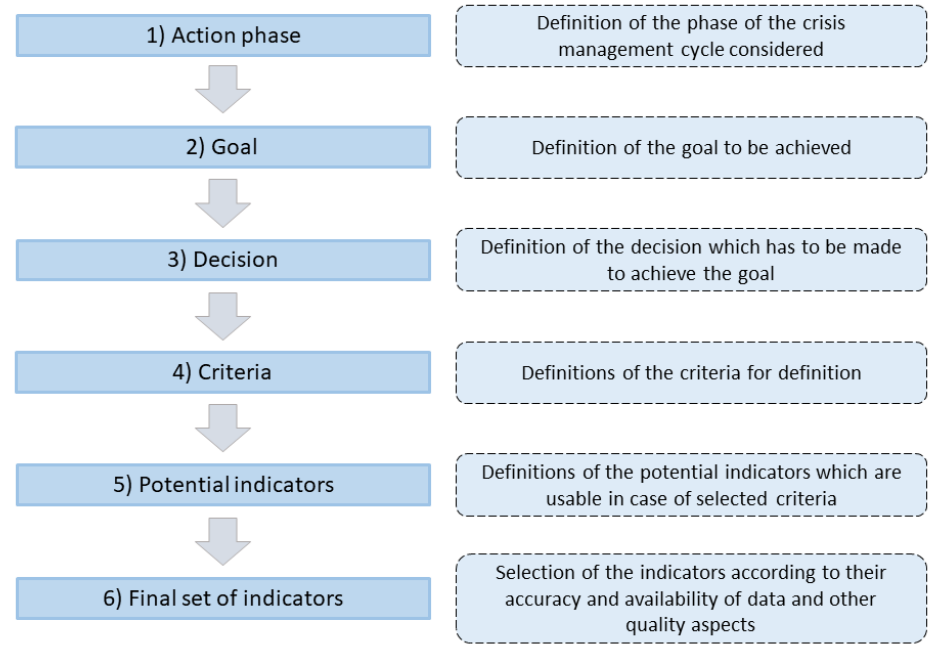
Figure 6. The methodology used to assess indicators [modified from 35].